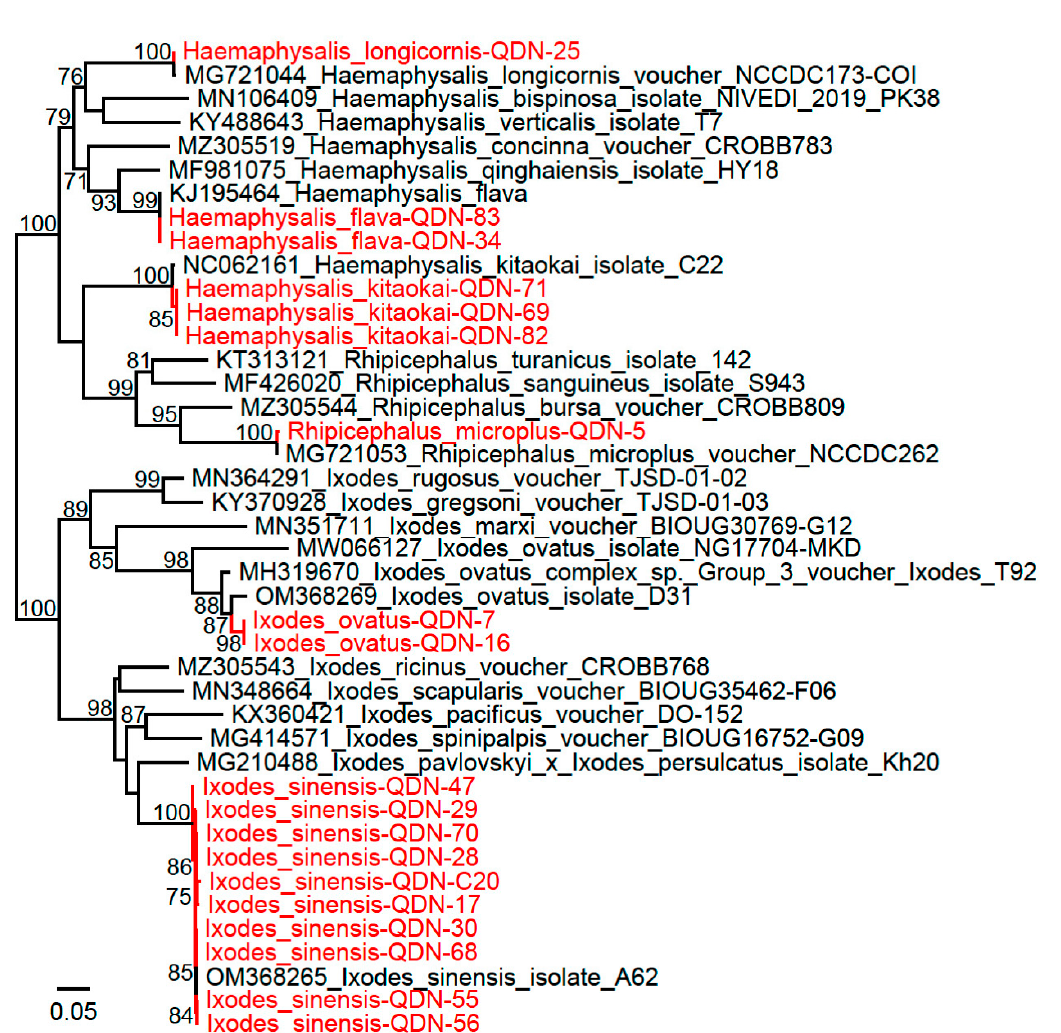
Figure 1. Phylogenetic trees based on the COI sequences of ticks from Guizhou Province. Red: Sequences obtained in this study. Table 1. Prevalence of Rickettsia and “ Candidatus Lariskella guizhouensis” in different tick species from Guizhou